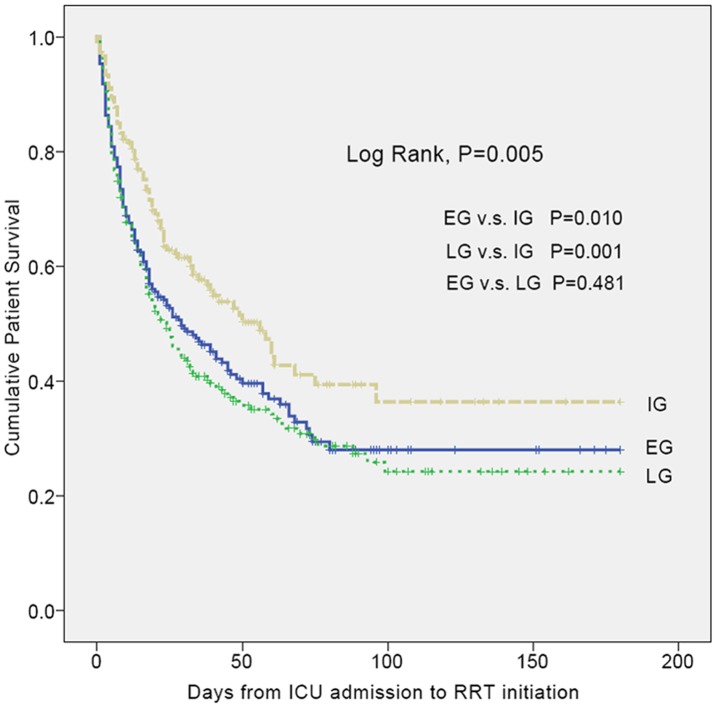
Estimated survival probability among EG, IG, and LG.The survival period was calculated from RRT initiation. EG (blue line, n = 243), IG (green line, n = 146), and LG (red line, n = 227) were defined as RRT initiation ≦ 1 days, 2–3 days, and ≧ 4 days after ICU admission, respectively. Abbreviations: EG, early group; ICU, intensive care unit; IG, intermediate group; LG, late group; RRT, renal replacement therapy.